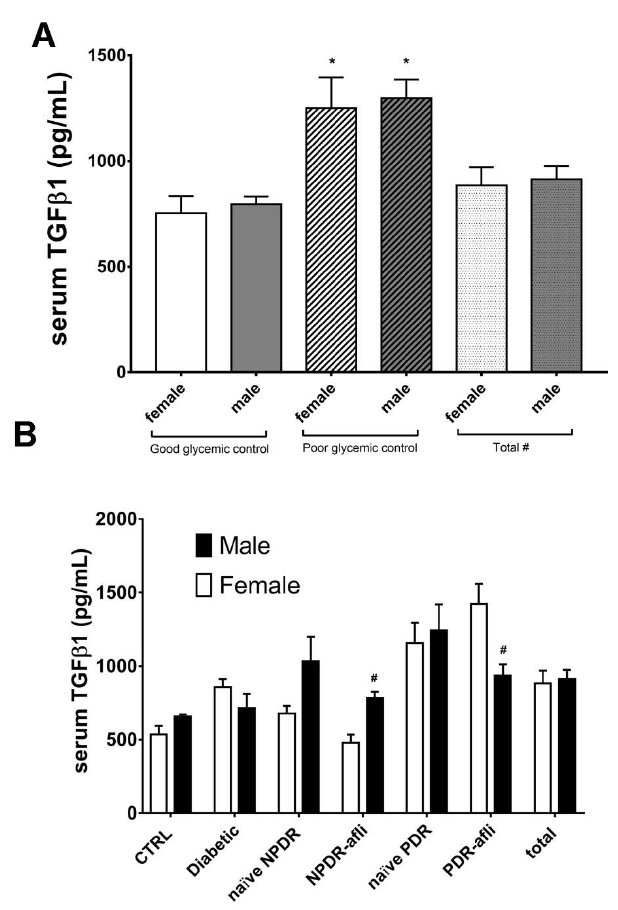
Figure 6. Glycemic control, group and gender e ff ects on TGF β 1 serum levels. The M-ANOVA post-hoc analysis shed light on fixed factors (independent variables) e ff ects on all analyzed dependent variables. A multivariate-ANOVA guided the stratification of TGF β 1 levels in terms of glycemic control and gender. ( A ) Both males and females, with reported poor glycemic control at enrollment, showed significantly ( p < 0.05) higher levels of TGF1 β , compared to other patients. The stratification of TGF β 1 on the basis of gender and subject group ( B ) showed that only PDR females treated with aflibercept had significantly ( p < 0.05) higher levels of TGF β 1, compared to males of the same group. * p < 0.05 vs. “good glycemic control” group; # p < 0.05 males vs. females.